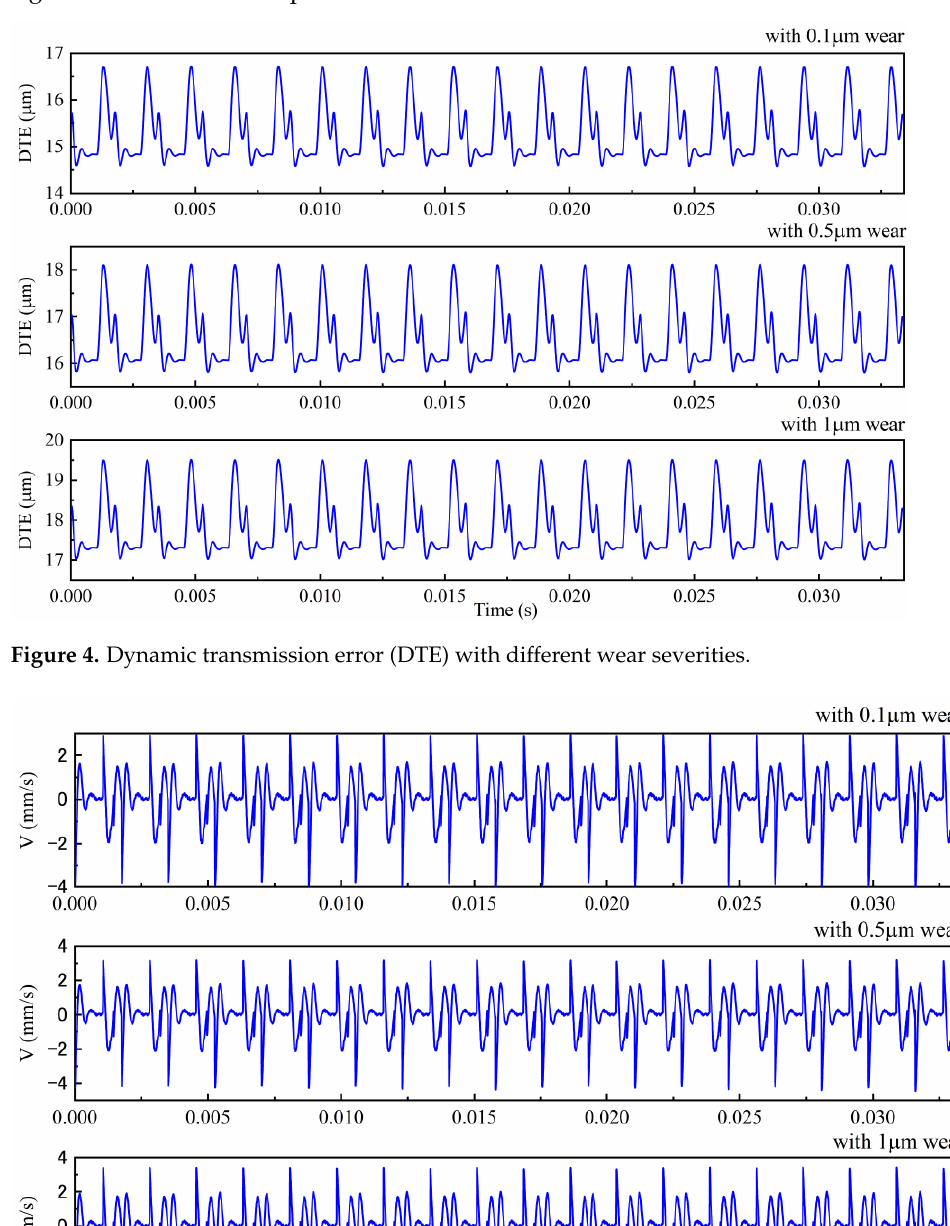
Figure 5. Vibrations of casing 𝑦̇ 𝑝 under different wear severities.